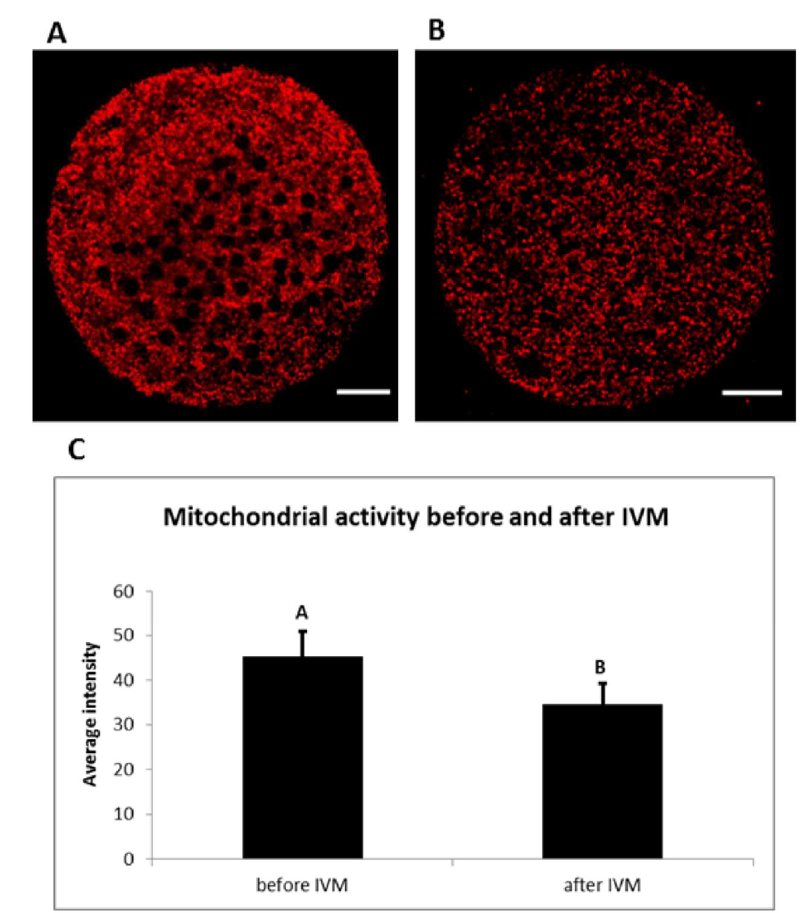
Figure 8. Mitochondrial activity during in vitro maturation (IVM). Representative images of porcine oocytes before ( A ) and after ( B ) in vitro maturation. Oocytes were stained by Mito Tracker Orange CMTM Ros (red color—active mitochondria). Scale bar represents 20 µm. The mean (±SD) of relative mitochondrial activity was significantly higher in oocytes before IVM than oocytes after IVM ( C ).